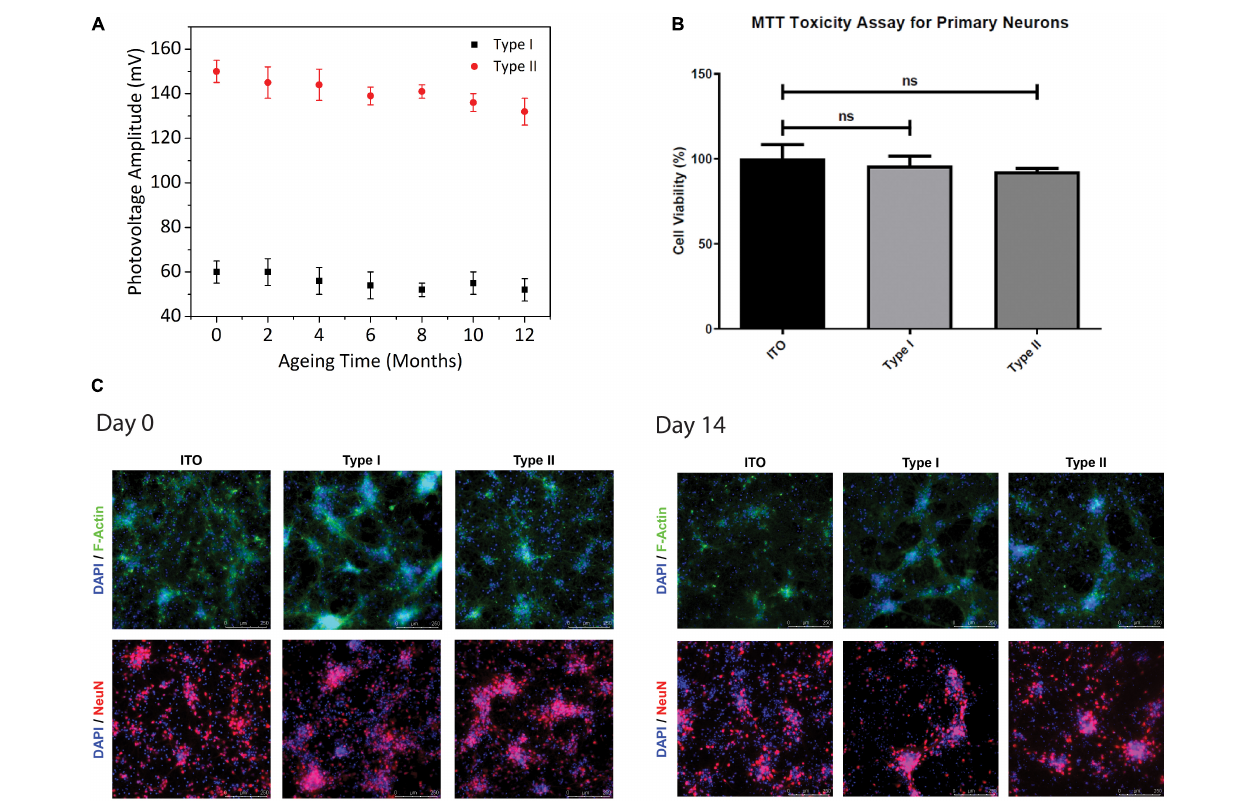
FIGURE 4 | Stability and biocompatibility of biointerfaces. (A) Photovoltage measurements of type I and type II biointerfaces in an accelerated aging test for aging period of 12 months (Mean ± SD, for N = 4). (B) Cell viabilities of primary hippocampal neurons cultured on type I and type II biointerfaces obtained from MTT biocompatibility assay analysis. Data was presented in a column graph plotting the mean with the standard deviation (Mean ± SD) (Four technical replicates were used in each of the three different experiments). Unpaired, two-tailed t-test was performed to determine the level of significance and * shows p < 0.05, which is considered as statistically significant and “ns” indicates a statistical non-significant difference. (C) Immunofluorescence images of primary hippocampal neurons and glia on type I, type II biointerfaces, and ITO controls at Day-0 and Day-14 after primary neuron isolation protocol. Primary hippocampal neurons co-stained with DAPI (blue), a DNA marker, Anti-NeuN antibody (red), a neural nucleus marker, and Anti-F-actin antibody (green), a cytoskeleton marker (Scale bar = 250 µ